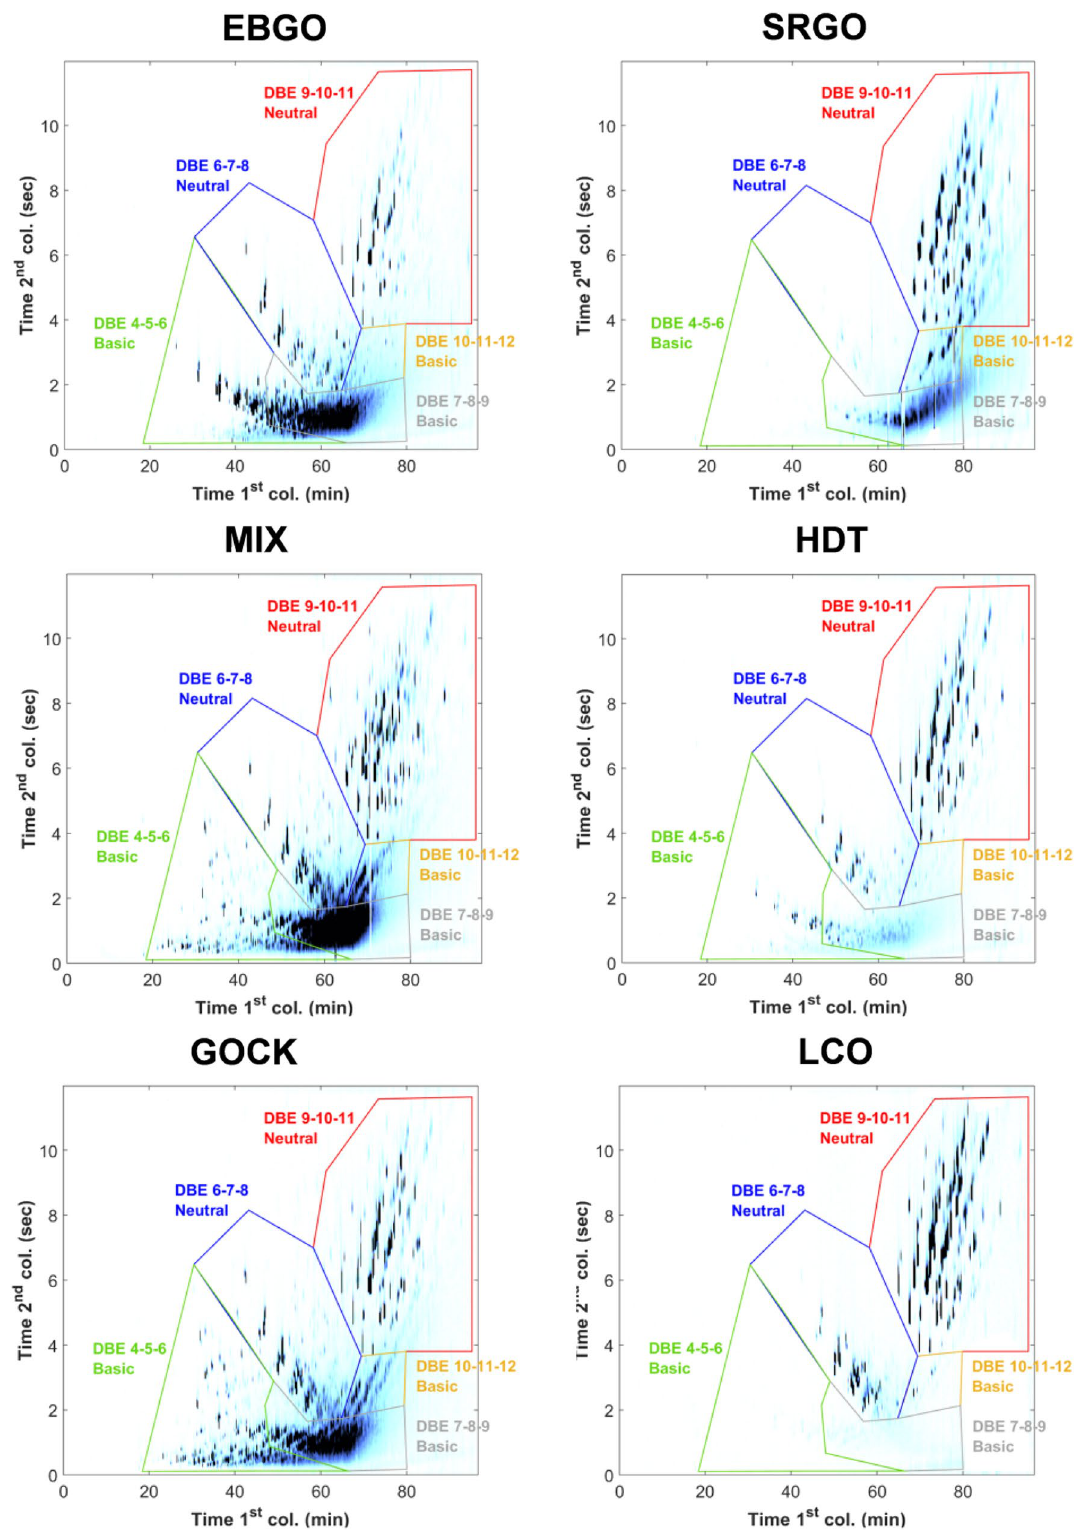
Figure 2. GC × GC-NCD chromatograms obtained for the different types of gas oils considered. The chromatograms were obtained using a home-made software 2D